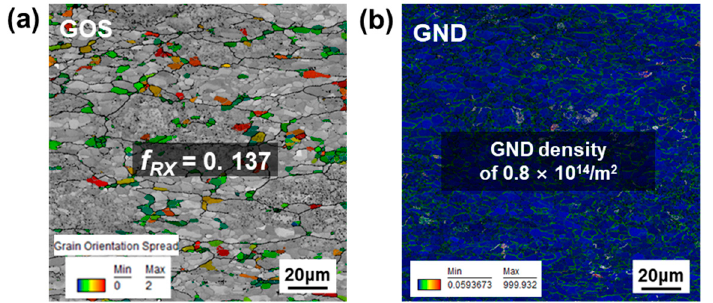
Figure 3. The EBSD analysis results of undeformed DF-W sample: ( a ) GOS map and ( b ) GND map.